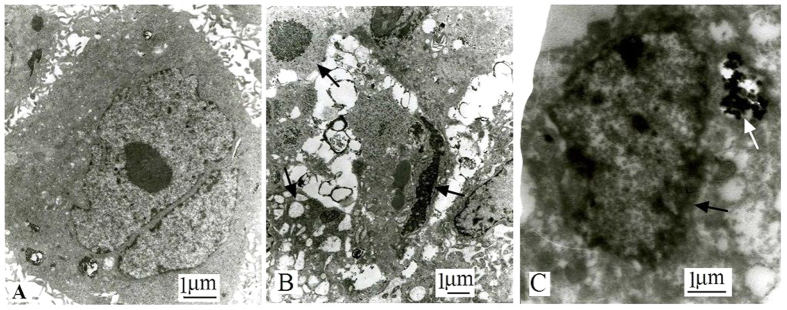
Xenograft hepatoma cells’ ultrastructure observed with TEM.(A) saline control group (×10000); (B,C) nuclide-gene-MFH group (B ×15000, C ×15000).